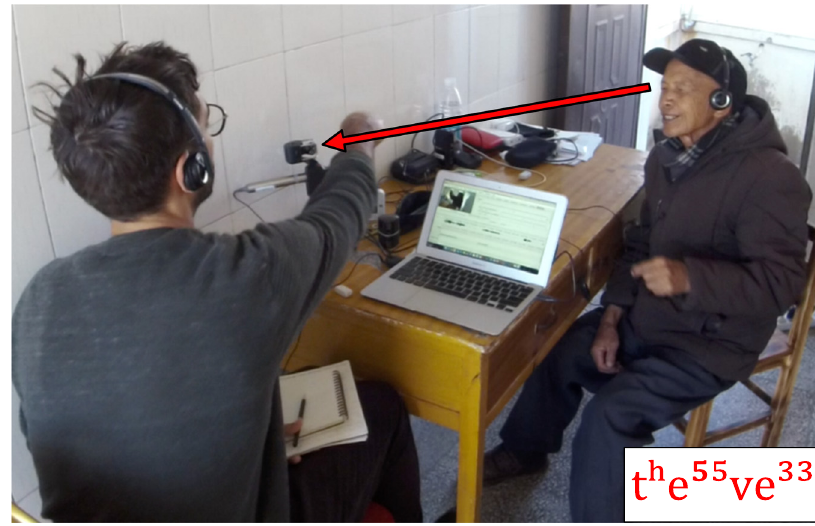
Figure 7: Addressee ’ s hand approaches the small lens prompting BLW to switch to addressee